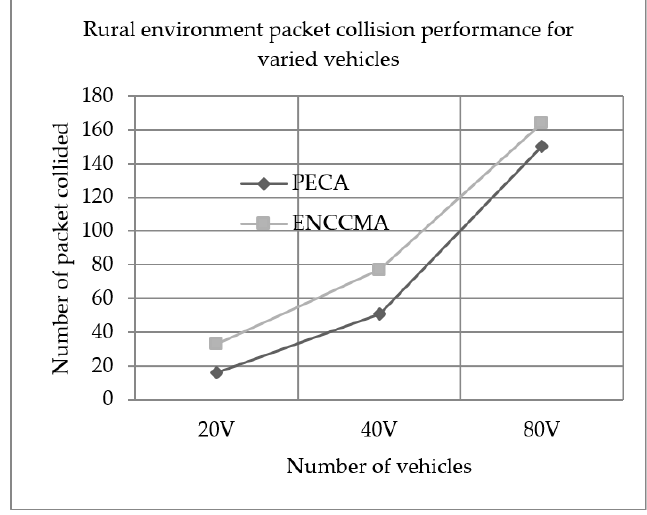
Figure 9. Rural environment packet collision performance for varied vehicles.